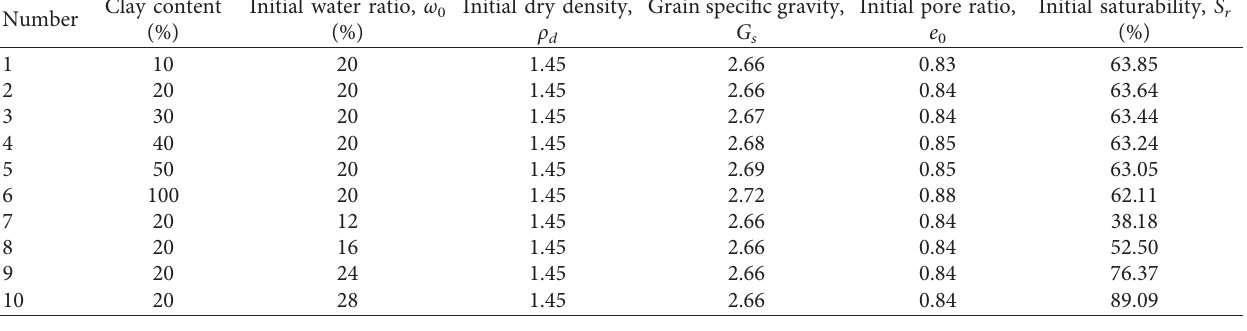
Table 2: Basic physical parameters of sand samples.